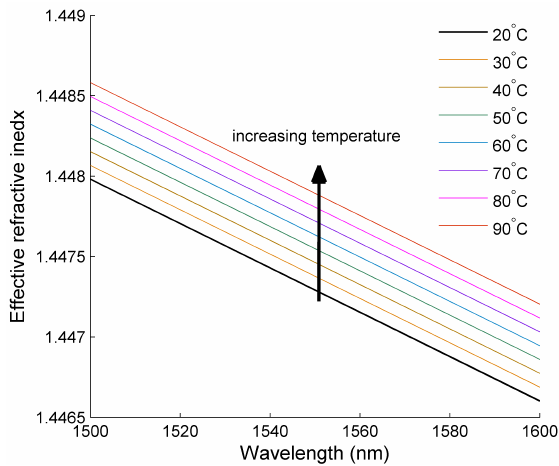
Figure 13. The calculated dispersion curve for the LP01 mode and how its effective index changes with respect to increasing